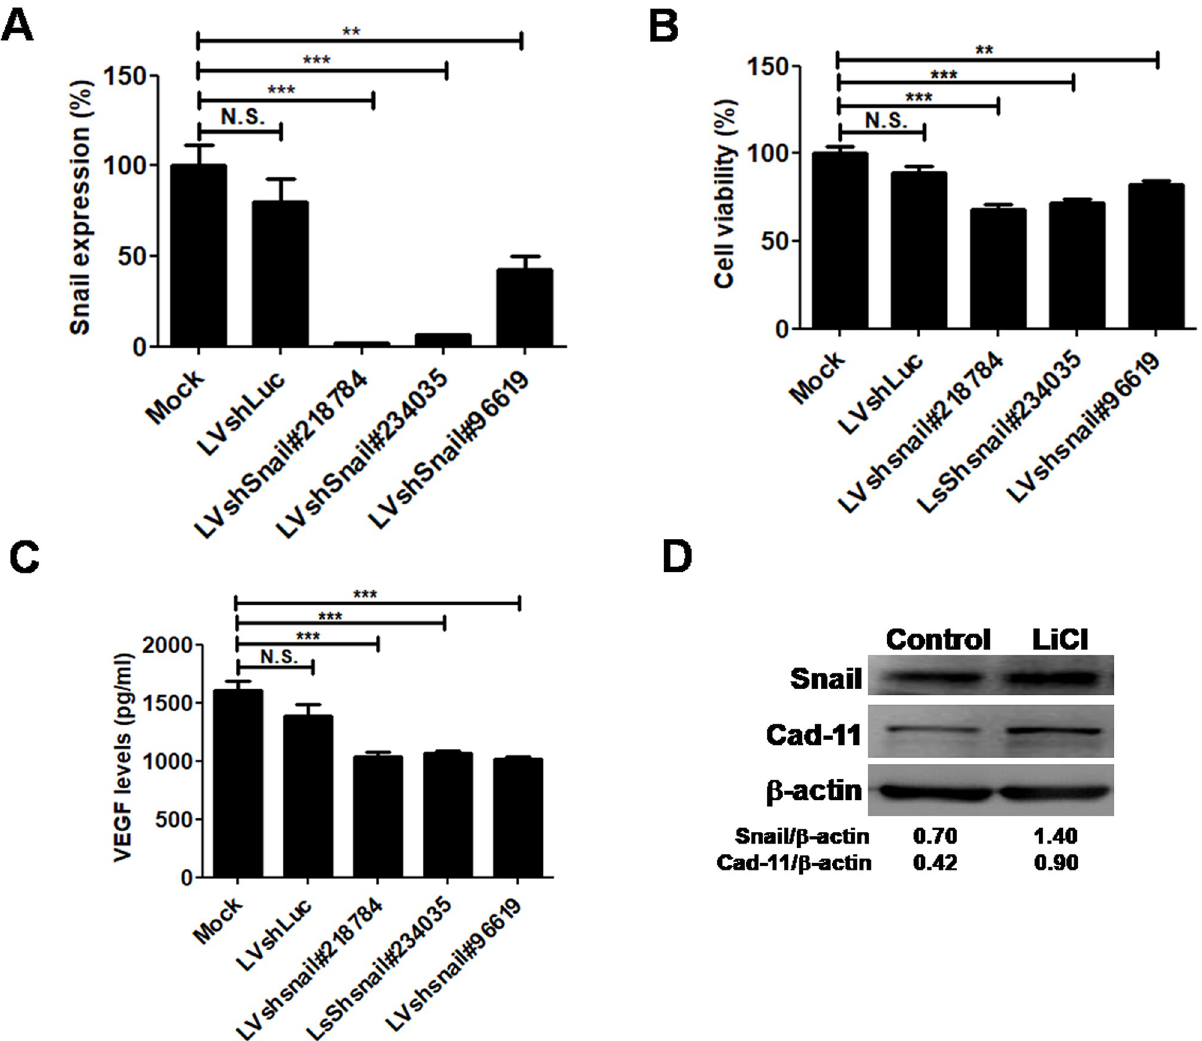
Fig 2. Snail, vascular endothelial growth factor (VEGF), and cadherin-11 (Cad-11) expressions and cell viability in short-hairpin RNA (shRNA) and lithium chloride(LiCl)-treated CIA FLSs. (A) Real-time PCR for Snail in FLSs from CIA rats transduced with lentiviral vectors expressing Snail (LVshSnail) and luciferase (LVshLuc)-specific shRNA. (B) Cell viability was determined by WST-8 analysis. (C) VEGF expression levels in LVshLuc and LVshSnail-transduced CIA FLSs. (D) Snail, Cad-11, and β -actin expressions in LiCl (10 mM) and DMSO-treated CIA FLSs for 24h. Values were expressed as mean ± SEM. N.S., not significant, �� p < 0.01, ��� p < 0.001.